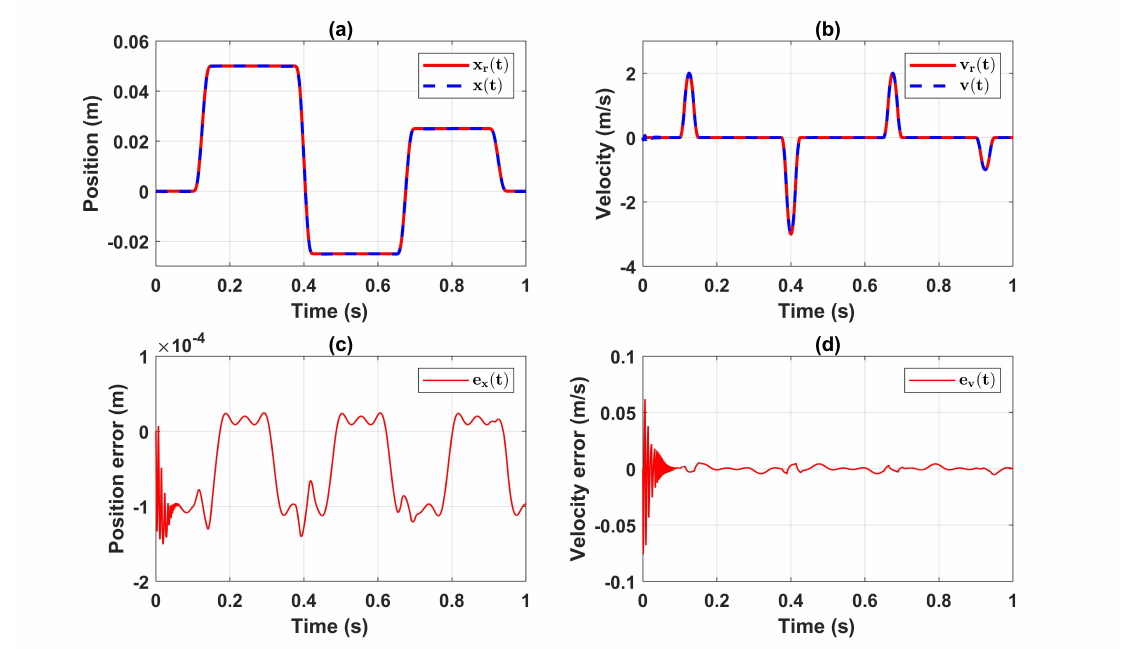
Figure 4. Time response of ( a ) position tracking; ( b ) velocity tracking; ( c ) position error; ( d ) velocity